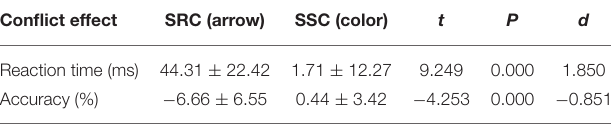
TABLE 3 | Conflict effect (Inc.-Con.) of the arrow and color flanker tasks. Conflict